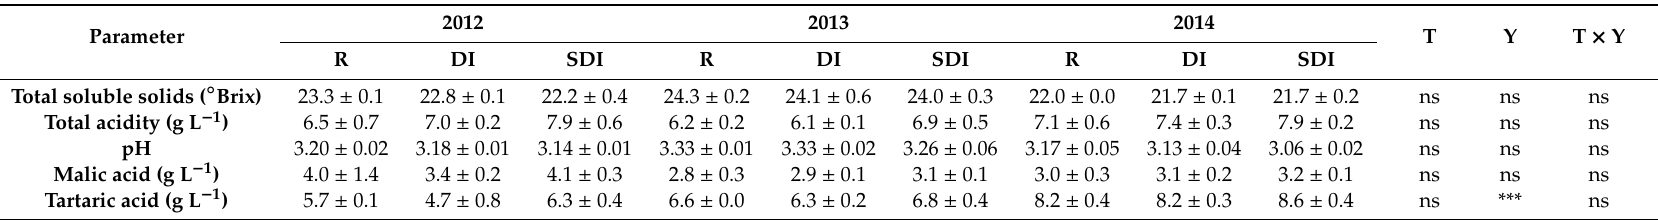
Table 3. General attributes of the musts (mean ± standard error) of Godello vines under three irrigation regimes over three seasons (2012, 2013, and 2014). The significances of the factors year and treatment, as well as their interaction are shown.